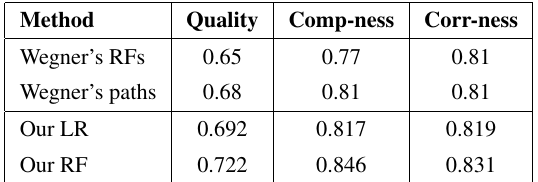
Table 1: Comparison of the pixel-wise classification obtained with the results of Wegner et al. (2015, Table